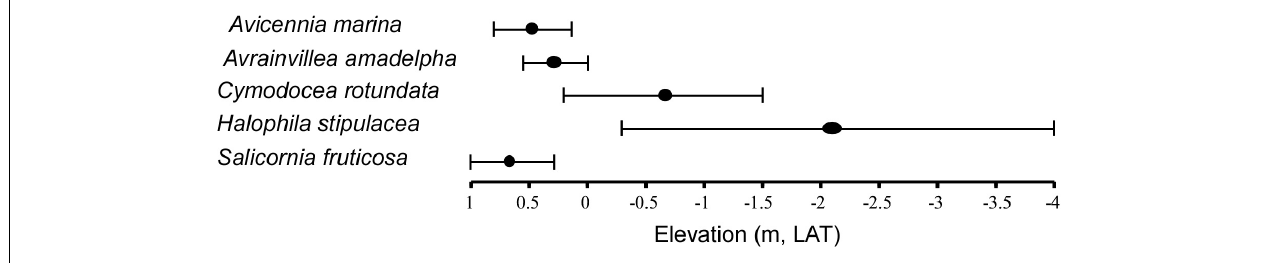
FIGURE 3 | Vegetation zonation along the transects across the intertidal sabkha vs. the elevation (m, LAT) of the Al-Kharrar Lagoon during March